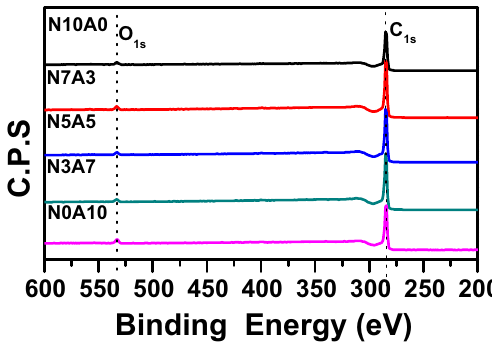
Figure 1. XPS graph depending on content of air flow.